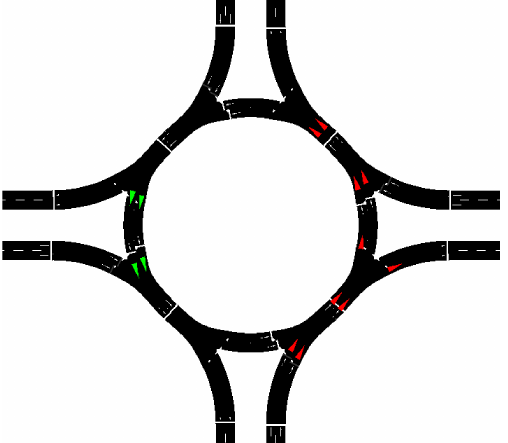
Figure 18. Snapshot of the SUMO simulation. Unbalanced traffic north–south. More vehicles from the south (red) and less vehicles from the north (green) enter the roundabout to compensate the traffic